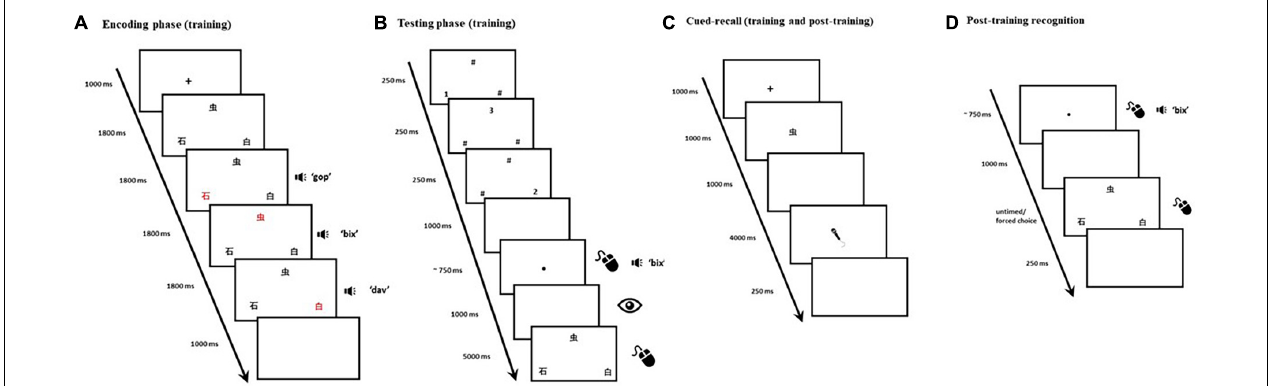
FIGURE 1 | Panels (A,B) depict the timeline of a single trial in the main training and recognition task. The encoding phase (A) was immediately followed by backward masking and then by the testing phase (B) . Panel (C) depicts the timeline of a single cued-recall trial (both training and post-training). Panel (D) depicts the timeline of a single trial in the post-training recognition test. The eye depicts recording of onscreen fixations, the microphone depicts when a verbal response was expected, and the mouse illustrates when a click was